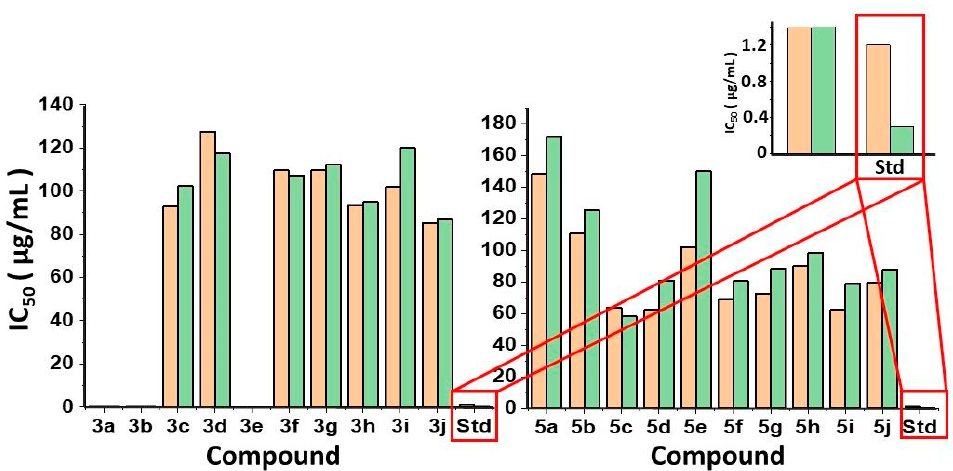
Figure 3. illustration of the IC 50 values for the compounds 3(a– ja; b; c; d; e; f; g; h; i; j ) and 5(a–ja ; b;